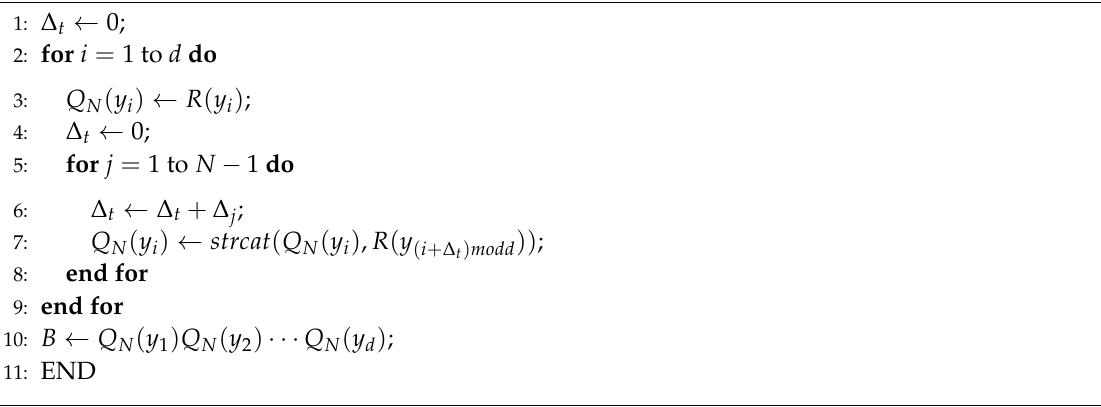
Algorithm 1 n -dimensional quantification